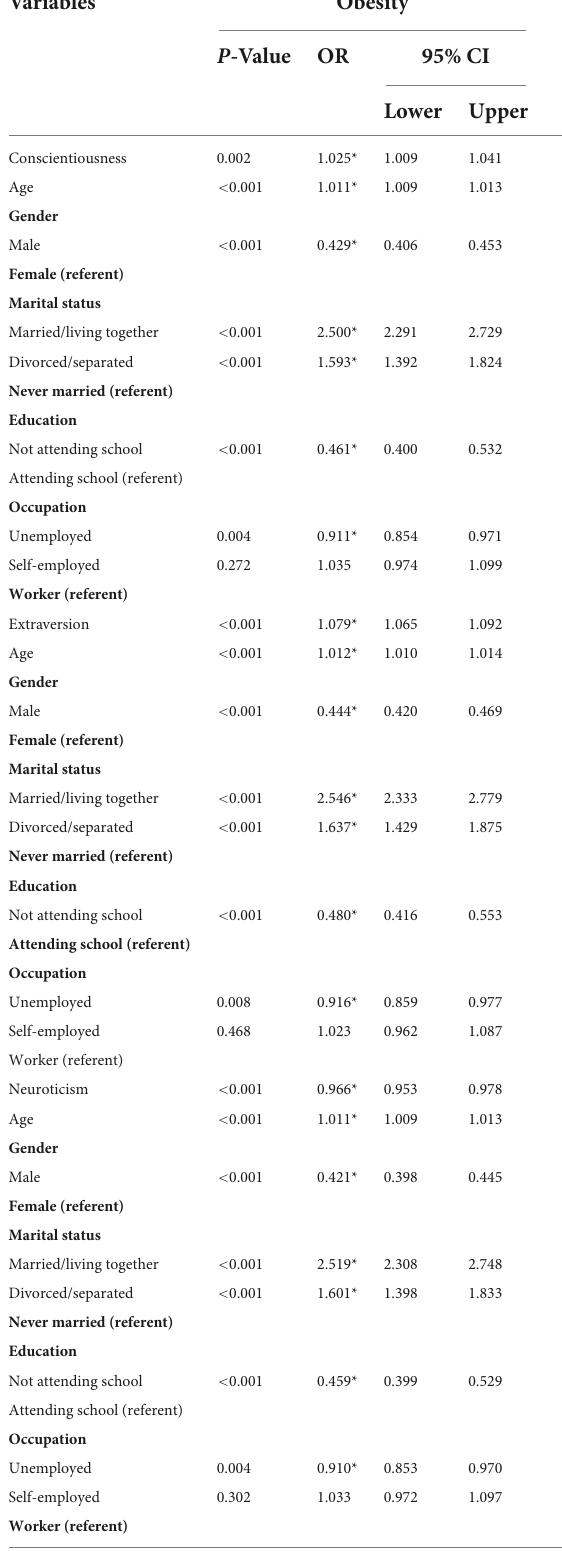
TABLE 4 Multivariate analysis between Big Five Personality Traits with obesity and control